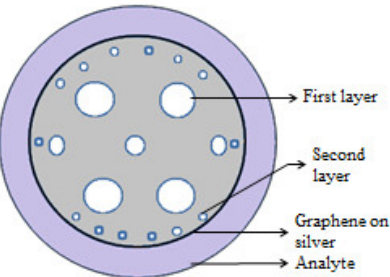
Figure 40. Dual core photonic bandgap fiber sensor; fabricated from a low index (n b ) host material and higher index (n r ) rod inclusions for analyte sensing (Figure courtesy from the reference [35]).